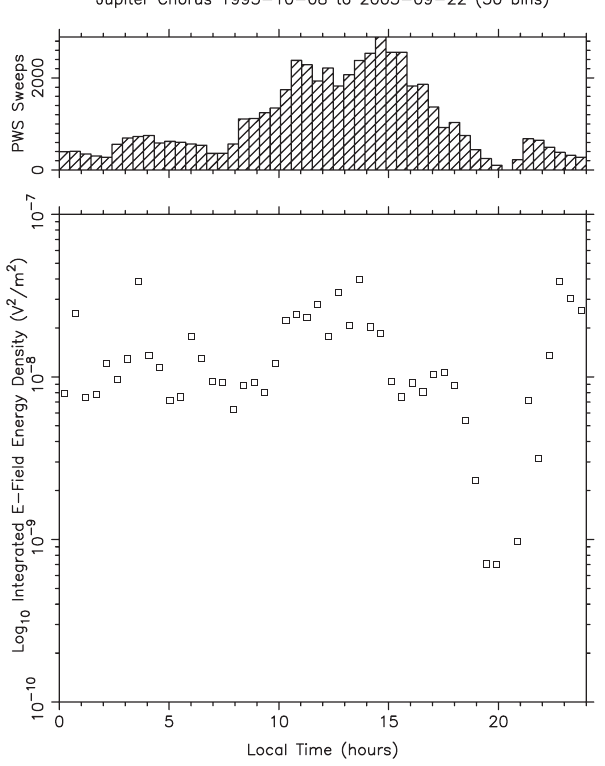
Fig. 7. Integrated chorus power as a function of local time.